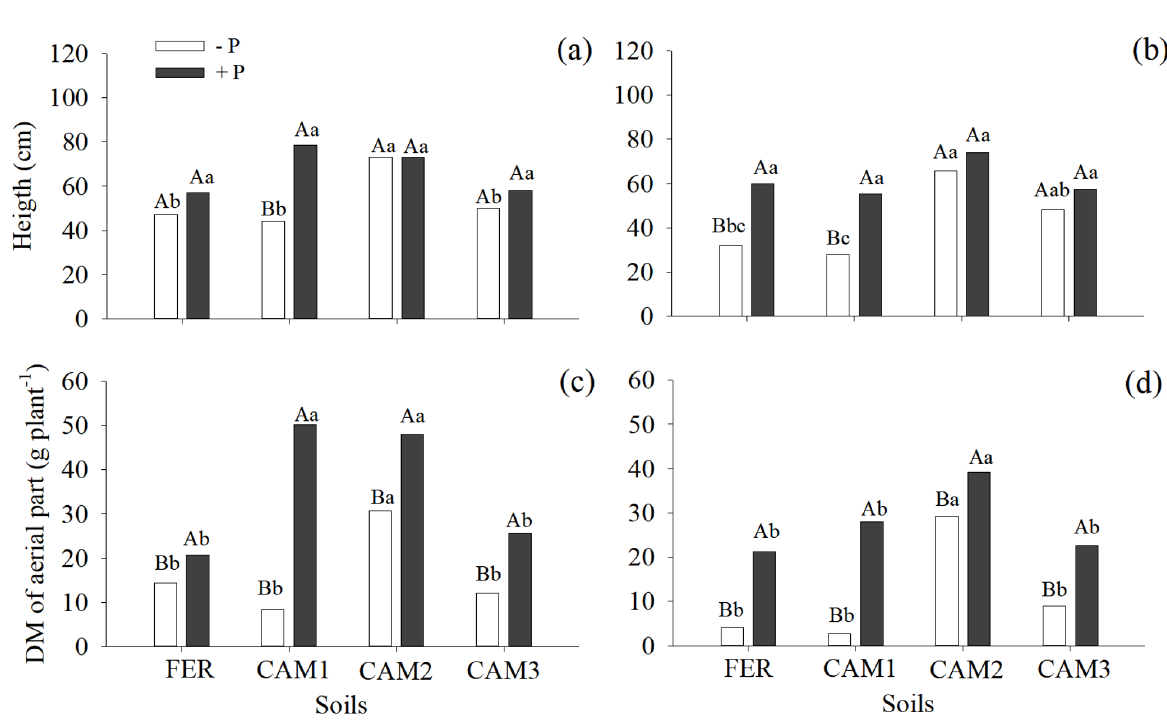
Figure 1 - Height ( a , b ) and aerial part dry matter ( c , d ) of yerba mate clones in response to P fertilization. at 210 days after experiment installation. Clone 1 (a and c). Clone 2 (b and d). Soils: FER - Ferralsol; CAM - Cambisol. Different values for lowercase (soils effect) and uppercase letters (P effect) indicate significant difference by the test Tukey